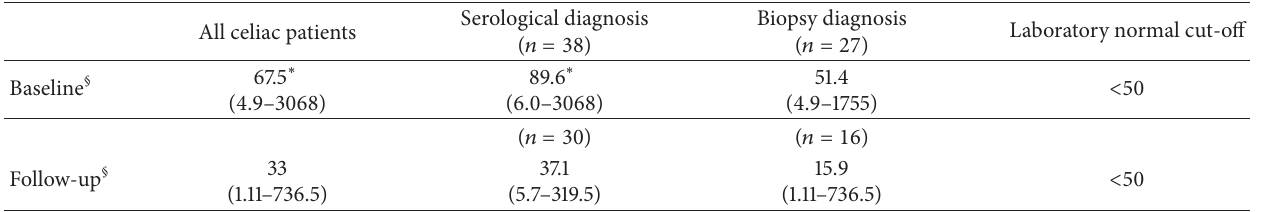
Table 3: Fecal calprotectin